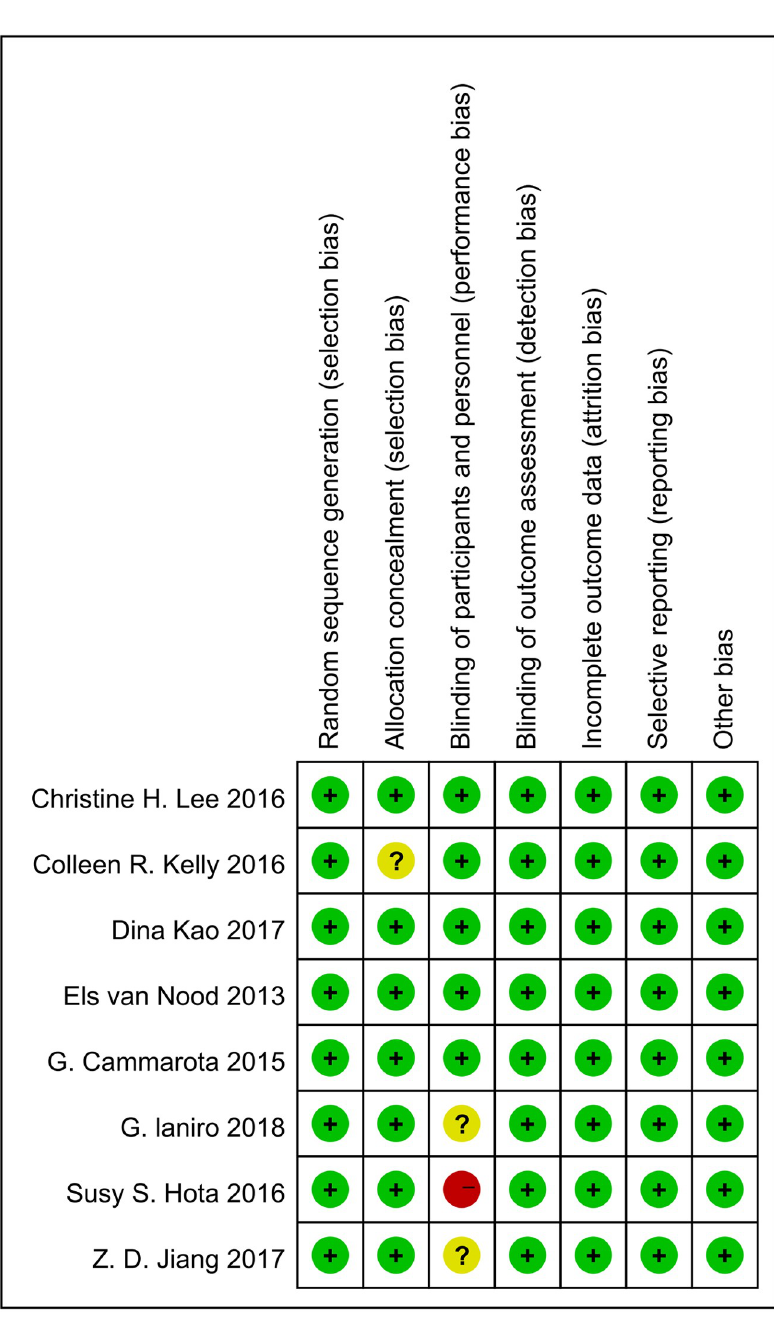
Fig 2. Risk of bias among the 8 included randomized controlled trials of fresh FMT for treating RCDI. The studies are identified by the first author’s name in the reference list of the publication. “+” in the green circle = low risk of bias; “?” in the yellow circle = unclear risk of bias; “-” in the red circle = high risk of